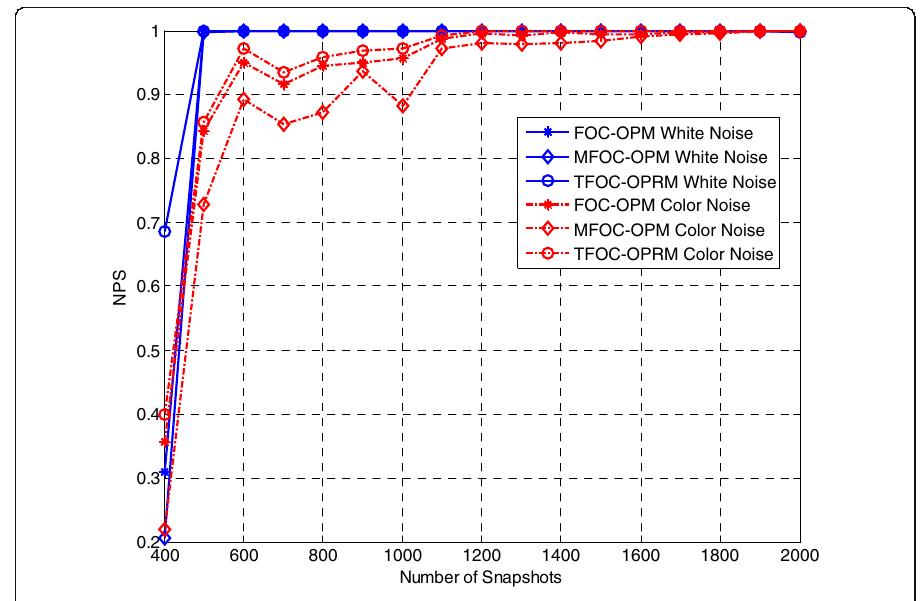
Fig. 5 NPS of the DOAs versus